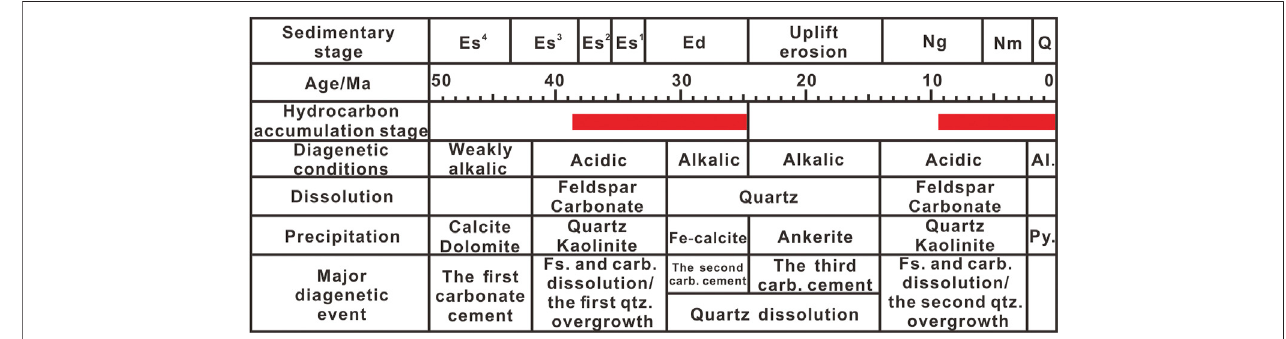
FIGURE 5 | General diagenetic sequence in sandstone reservoir in the Dongying Depression.